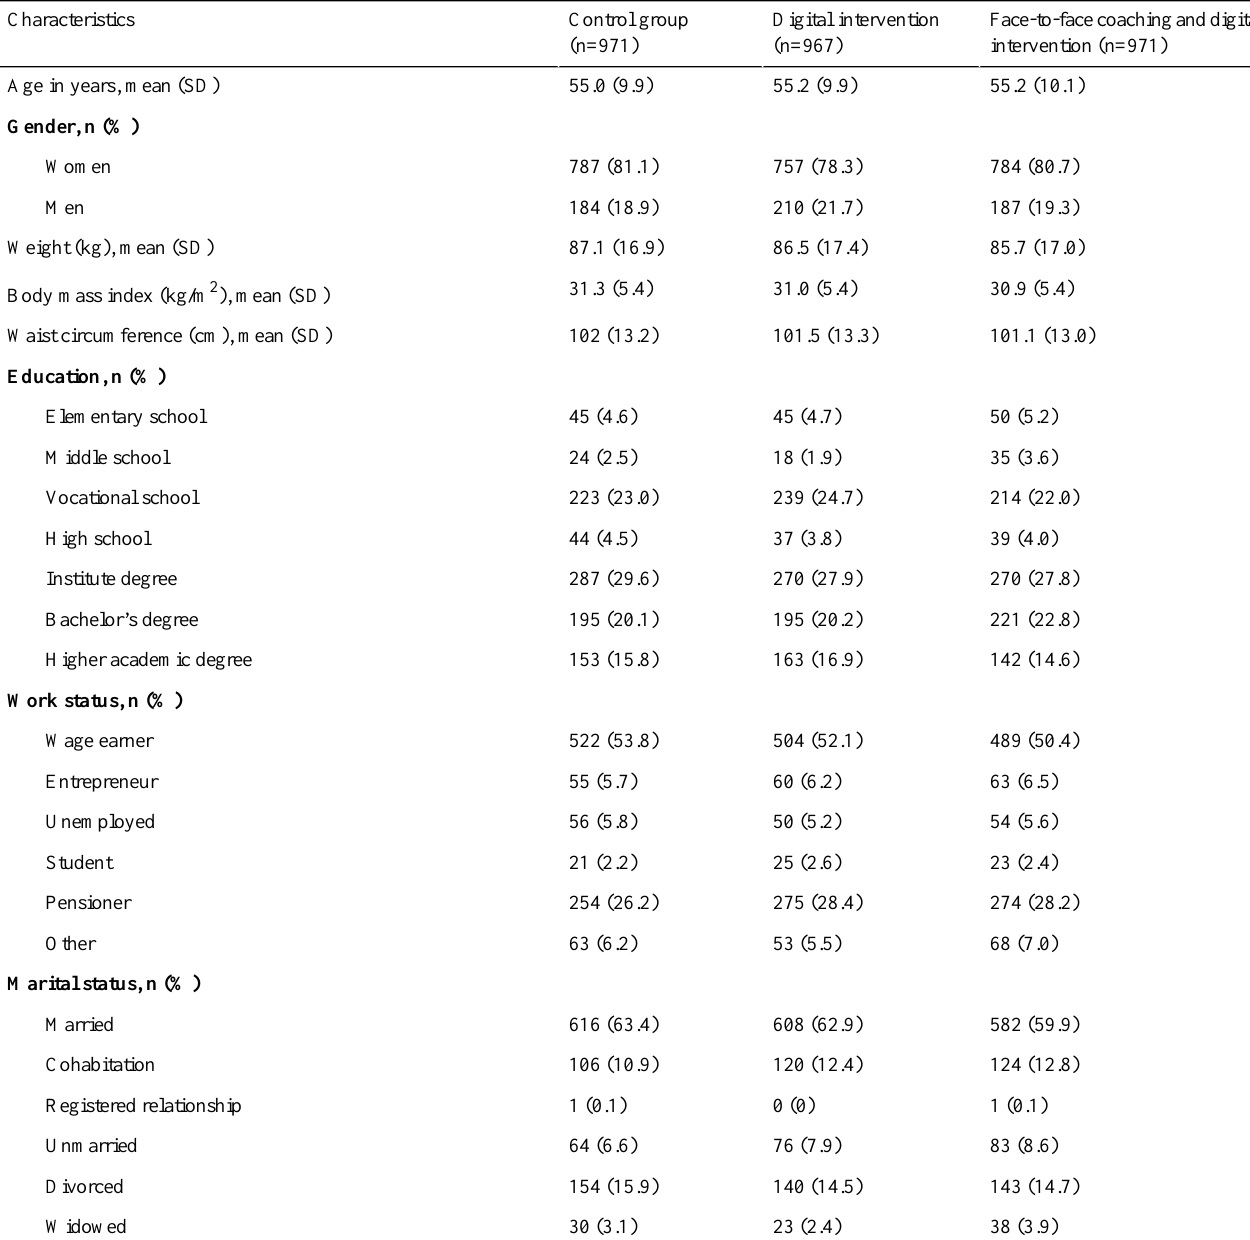
Table 1. Participant characteristics (n=2909).